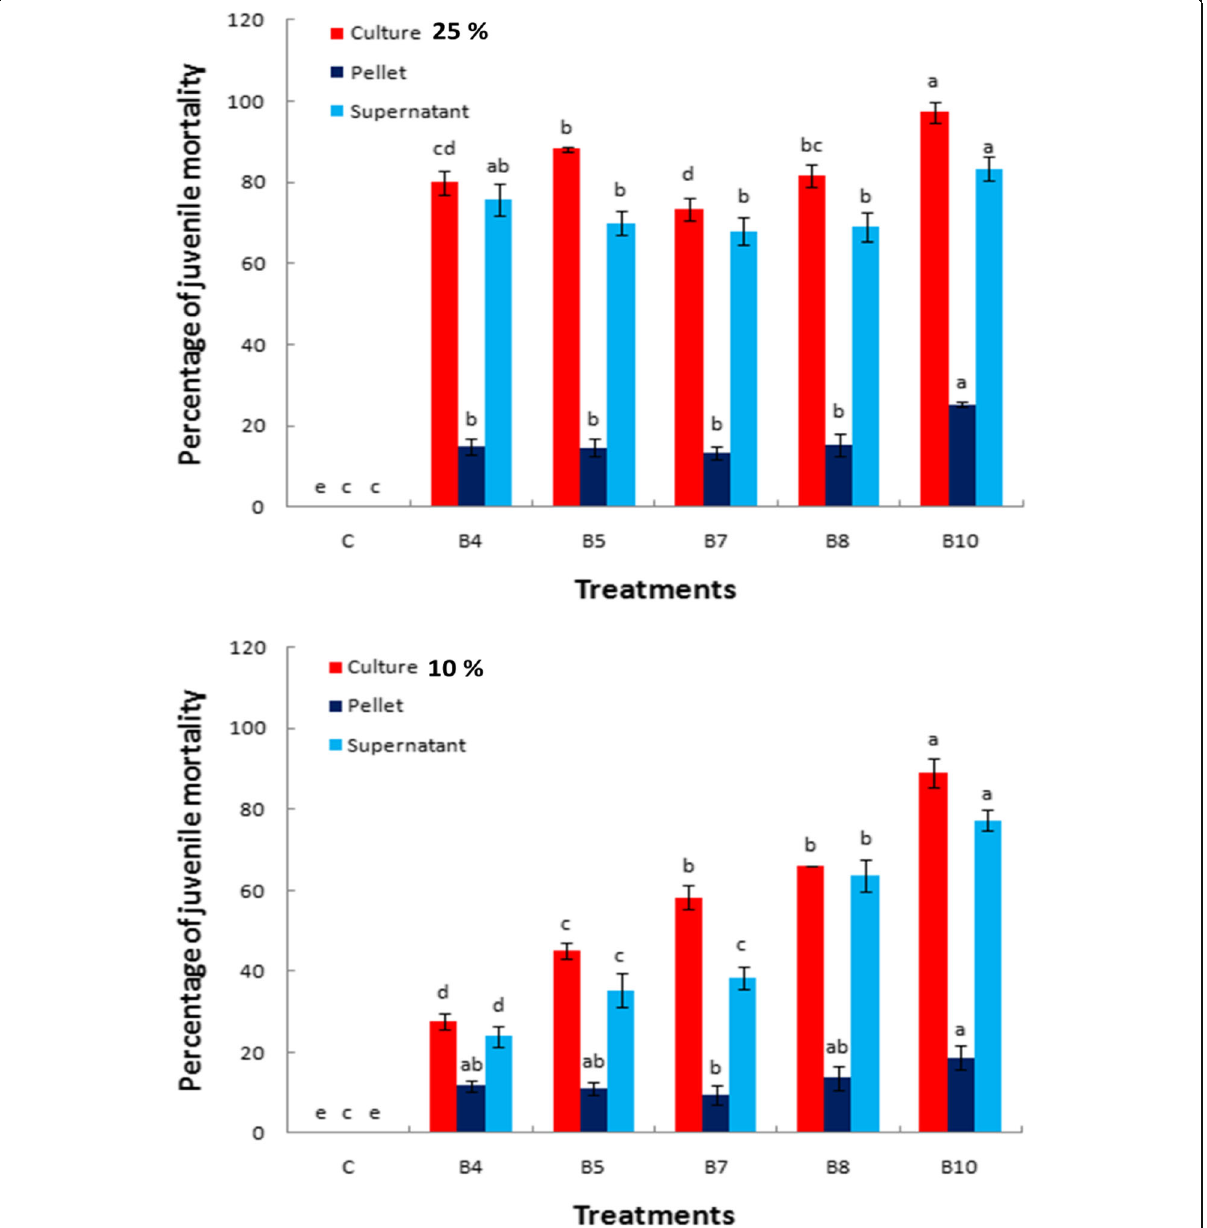
Fig. 4 Effect of culture broth, cell pellet, and supernatant of five Bacillus subtilis isolate (B4, B5, B7, B8, and B10, C is a control) on juvenile mortality of Meloidogyne incognita at a concentration of 25% and 10%. Values with the identical letters above the bar are not significantly different at P <0.05